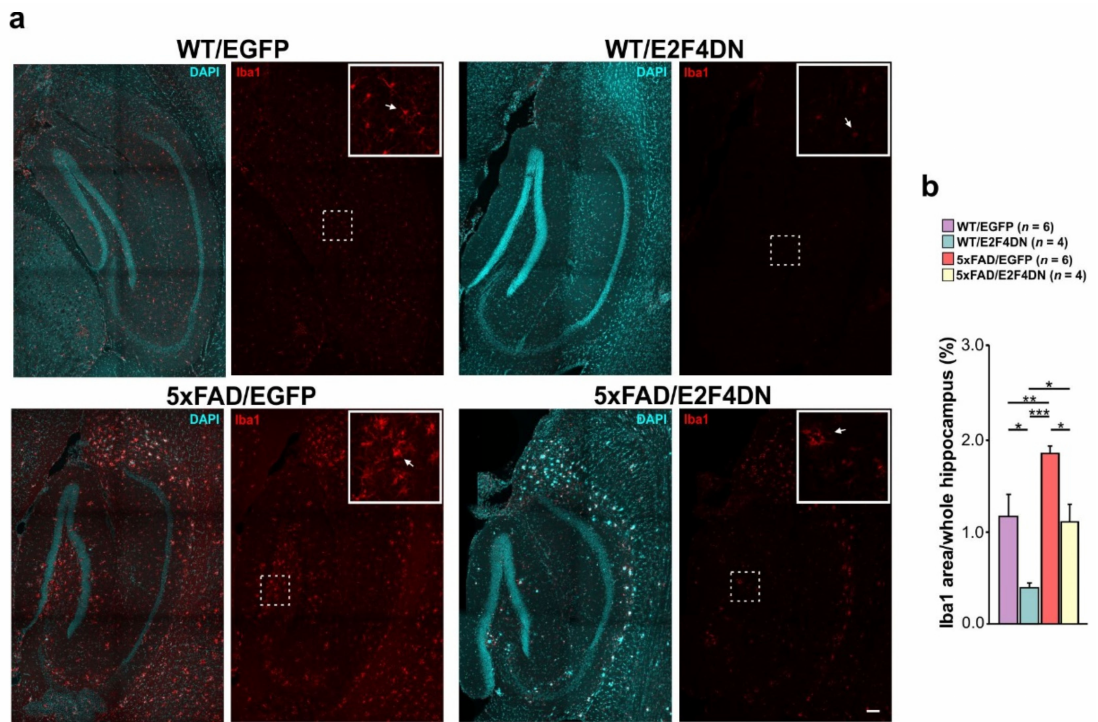
Figure 4. Attenuation of microgliosis by E2F4DN in the hippocampus of 1-year-old 5xFAD mice. ( a ) Iba1 immunostaining (arrow) in the hippocampus of mice with the indicated genotypes. Inserts show the high magnifications of the indicated dashed boxes. DAPI counterstaining was included to identify the hippocampus structure. ( b ) Percentage of the area occupied by Iba1 immunostaining in the hippocampus. * p < 0.05; ** p < 0.01; *** p < 0.001 (one-way ANOVA, followed by post hoc Newman-Keuls). Scale bar: 100 µ